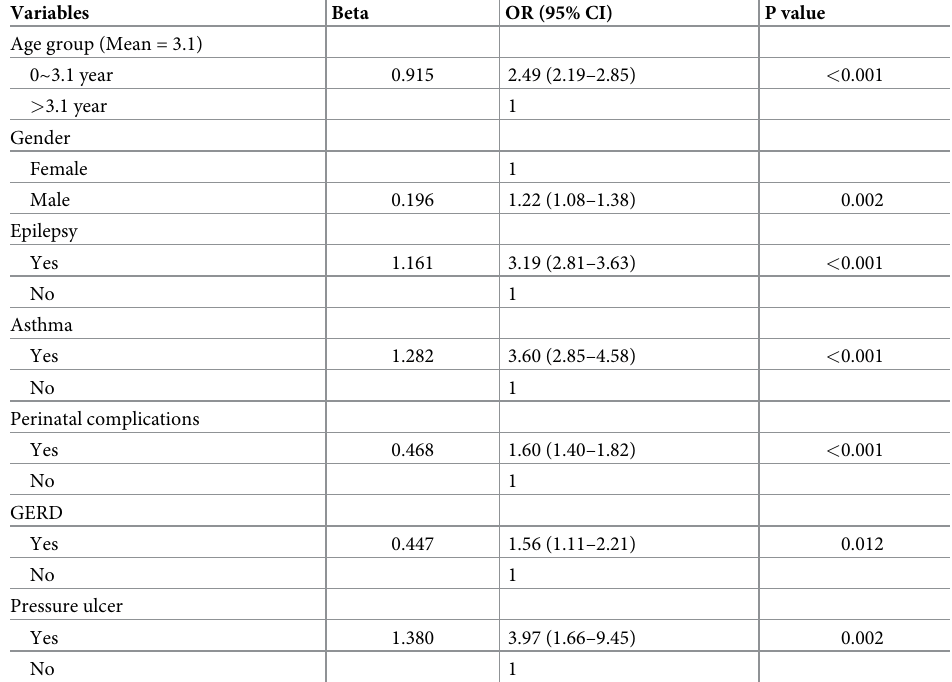
Table 3. Stepwise logistic regression analysis for severe pneumonia among children and young people with � 5 days inpatient care and none, n =